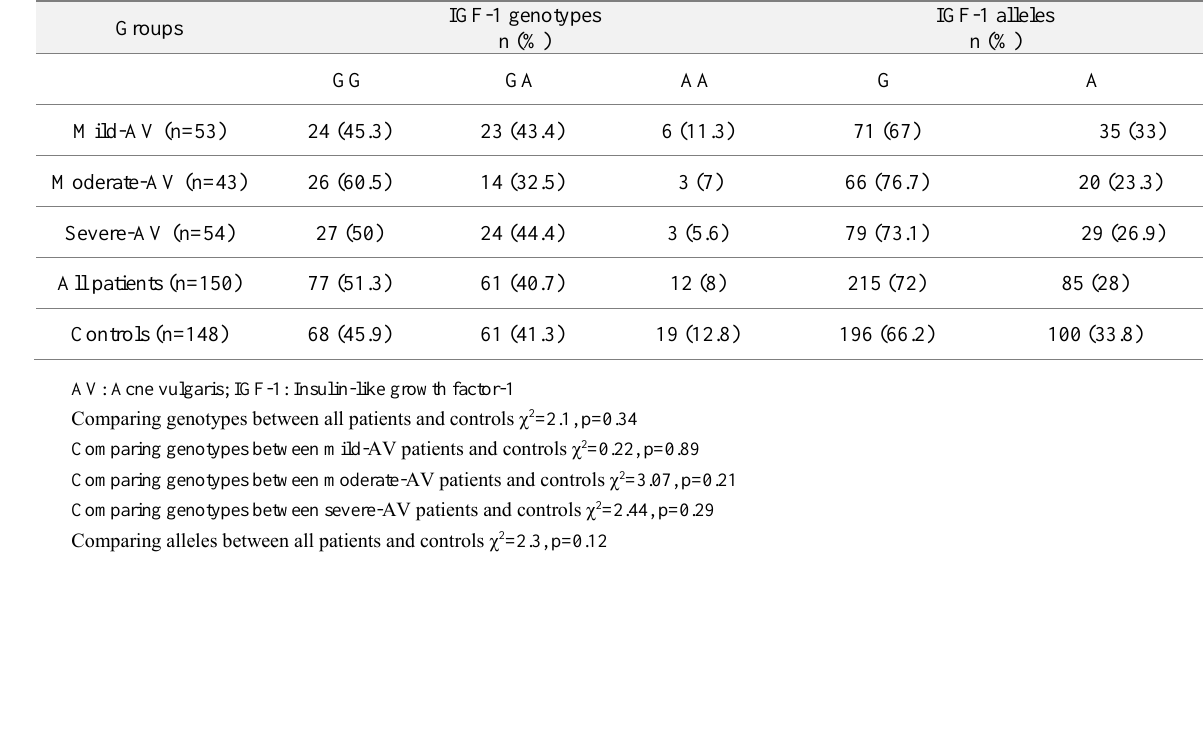
Table 3. Comparison of the IGF-1 genotype and allele frequencies between patients with mild-, moderate-, and severe-AV and